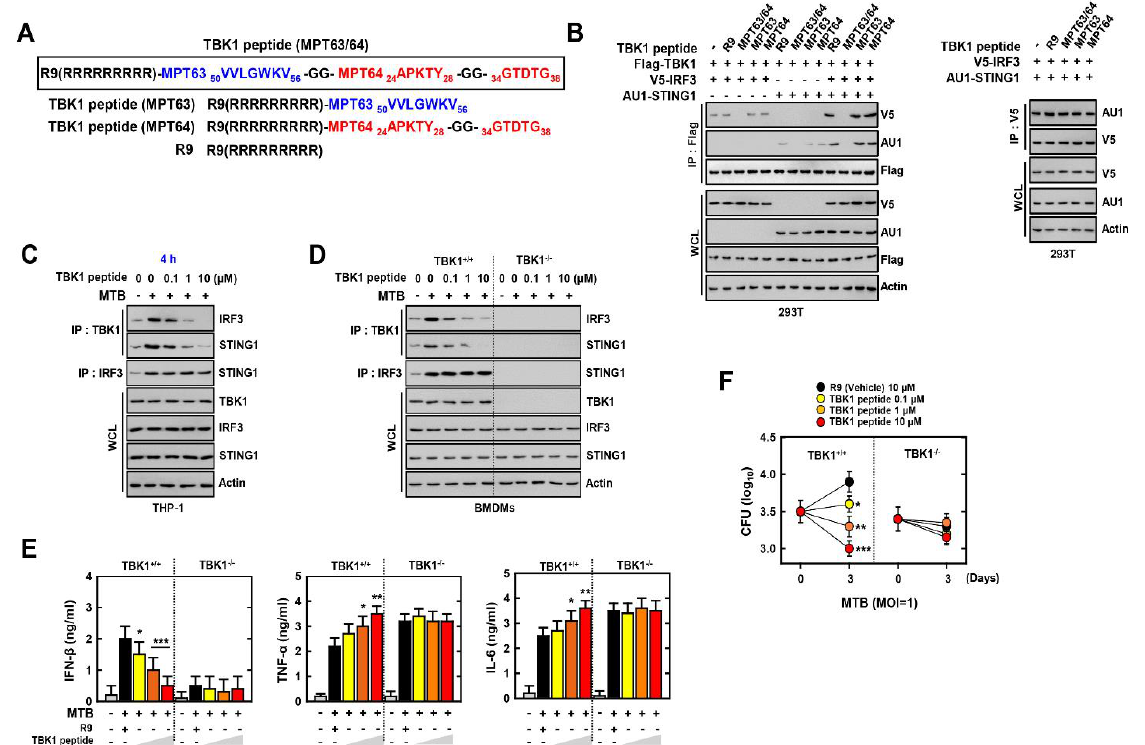
Figure 3. TBK1 peptide eliminates MTB by decreasing the STING1–TBK1–IRF3 pathway. ( A ) Schematic design of TBK1 peptide and its mutants. ( B ) 293T cells were transfected with V5-IRF3 and/or AU1-STING1 and treated TBK1 peptide or its mutants for 6h (1 µM) with Flag-TBK1 (left) or without Flag-TBK1 (right). 293T cells were used for IP with αFlag or αV5, followed by IB with αV5, αAU1 and αFlag. WCLs were used for IB with αV5, αAU1, αFlag, and αActin. ( C , D ) THP-1, TBK1 +/+ or TBK1 -/- BMDM cells were infected by MTB for 4 h and treated TBK1 peptide at various concentrations. After 4 h, THP-1 cells were used for IP with αTBK1 or αIRF3, followed by IB with αIRF3 and αSTING1. WCLs were used for IB with αTBK1, αIRF3, αSTING1, and αActin. ( E ) TBK1 +/+ or TBK1 -/- BMDM cells were infected by MTB for 4 h and treated TBK1 peptide at various concentrations. After 18h, supernatants of BMDMs were used for analysis of the level of IFN-β, TNF-α, and IL-6 by ELISA. ( F ) The burden of MTB was evaluated after 3 d in MTB infected TBK1 +/+ or TBK1 -/- BMDMs with vehicle or TBK1 peptide. The data are representative of four independent experiments with similar results ( B – F ). Significant differences (* p < 0.05; ** p < 0.01; *** p < 0.001) compared with rVehicle-treated